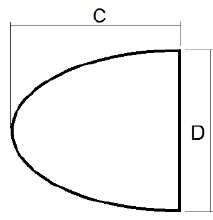
Figure 5. Cross area of mirror which is considered to optimise